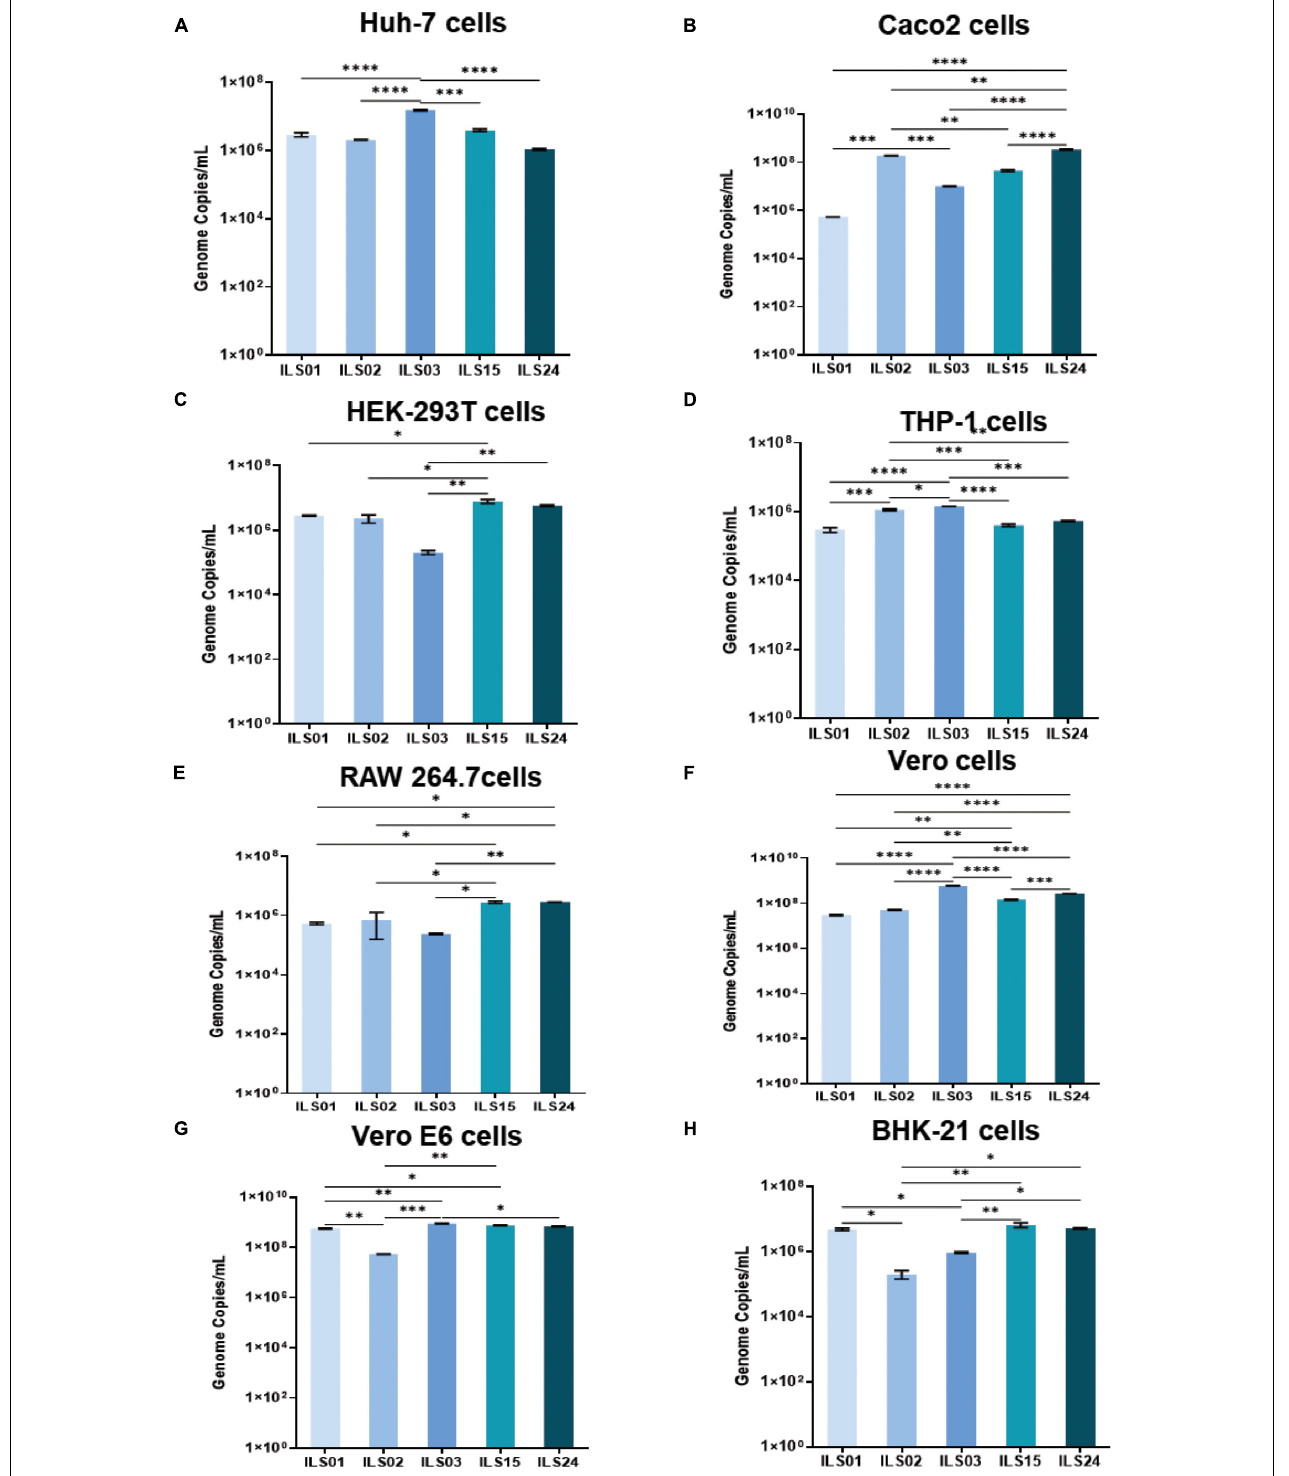
FIGURE 4 | Susceptibility of various cell lines to the SARS-CoV-2 isolates. Different cell lines were subjected to infection with 0.1 MOI of respective isolates. At 24 hpi, the viral load in the culture supernatants was determined by absolute quantification of viral genome copies. Graphs depicting the viral copies per milliliter of the supernatant in Huh7 (A) , Caco 2 (B) , HEK 293T (C) , THP1 (D) , RAW 264.7 (E) , Vero (F) , Vero E6 (G) , and BHK-21 (H) cells. Data are the mean value ± SD ( n = 3). Statistical significance was determined using one-way ANOVA; * P < 0.05; ** P < 0.01; *** P < 0.001; **** P < 0.0001 ns, not significant ( P > 0.05). Non-significant value is not